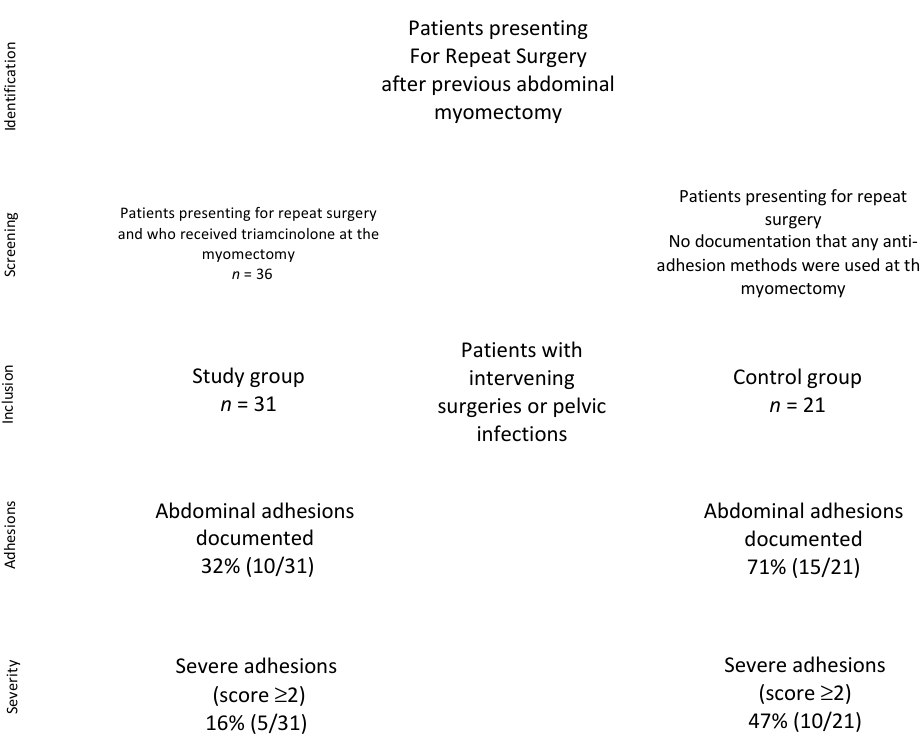
Figure 1. Study design and patient inclusion.